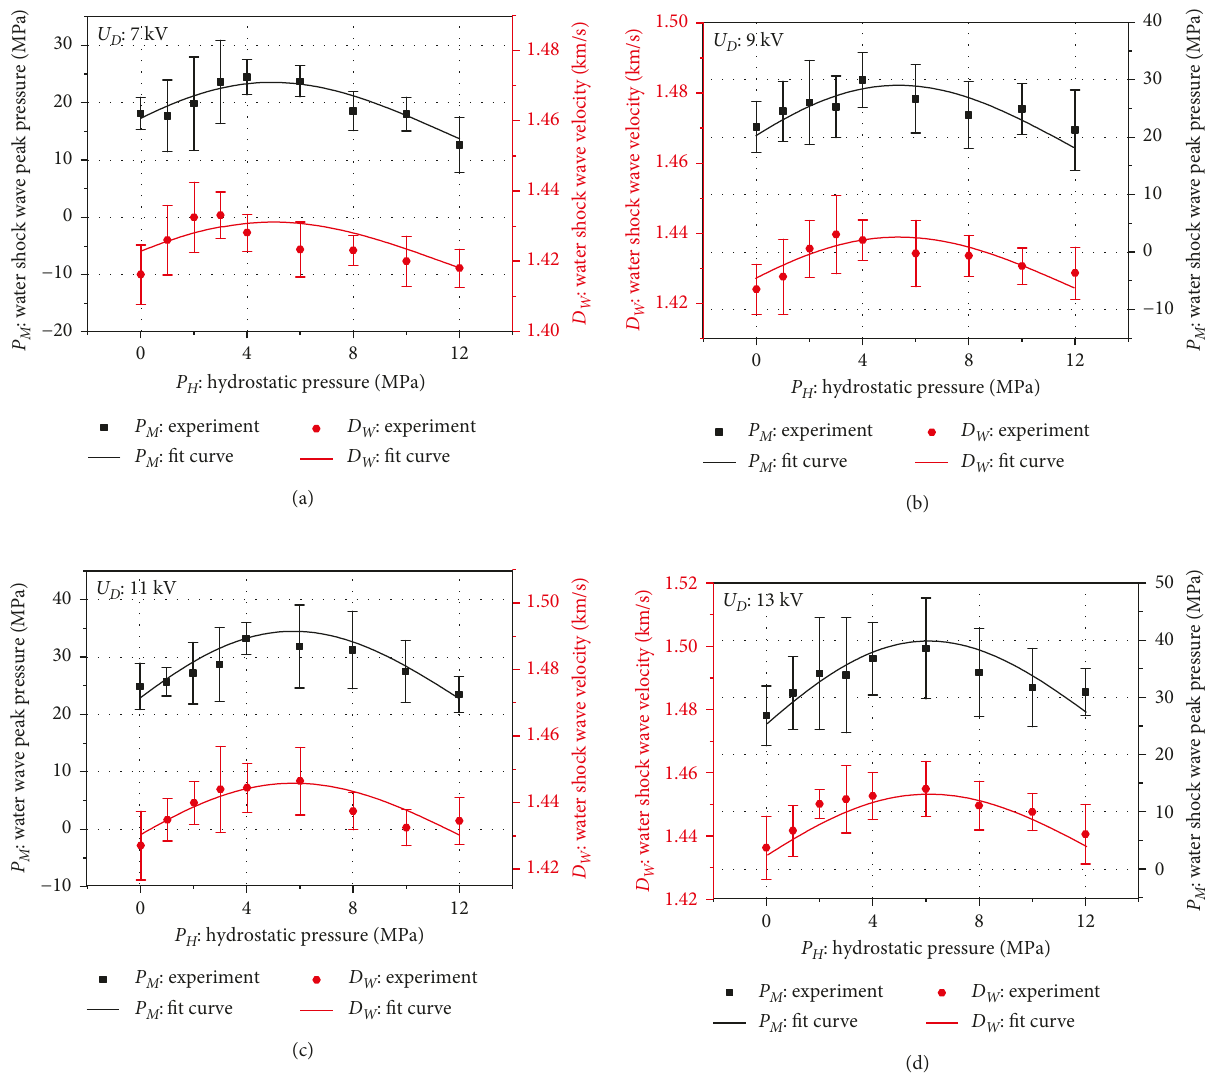
Figure 9: Binary diagrams showing the correlations between P and (d) 13